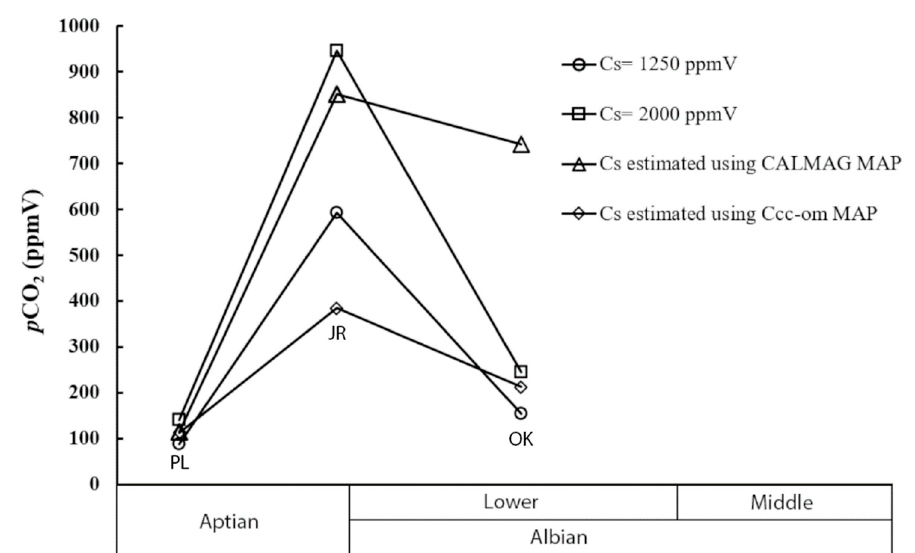
Figure 5. A plot of the average p CO 2 estimates calculated with C s values of 1250 (open circles) and 2000 (squares) ppmV. The average estimated atmospheric p CO 2 values calculated using C s values based on mean annual precipitation estimates (CALMAG weathering index estimates) are shown as open triangles. The average estimated atmospheric p CO 2 values calculated using C s values based on mean annual precipitation estimates ( Δ 13 C cc-om proxy ) are shown as open diamonds. The localities are labeled as follows: Proctor Lake (PL), Jones Ranch (JR), and Oklahoma (OK).